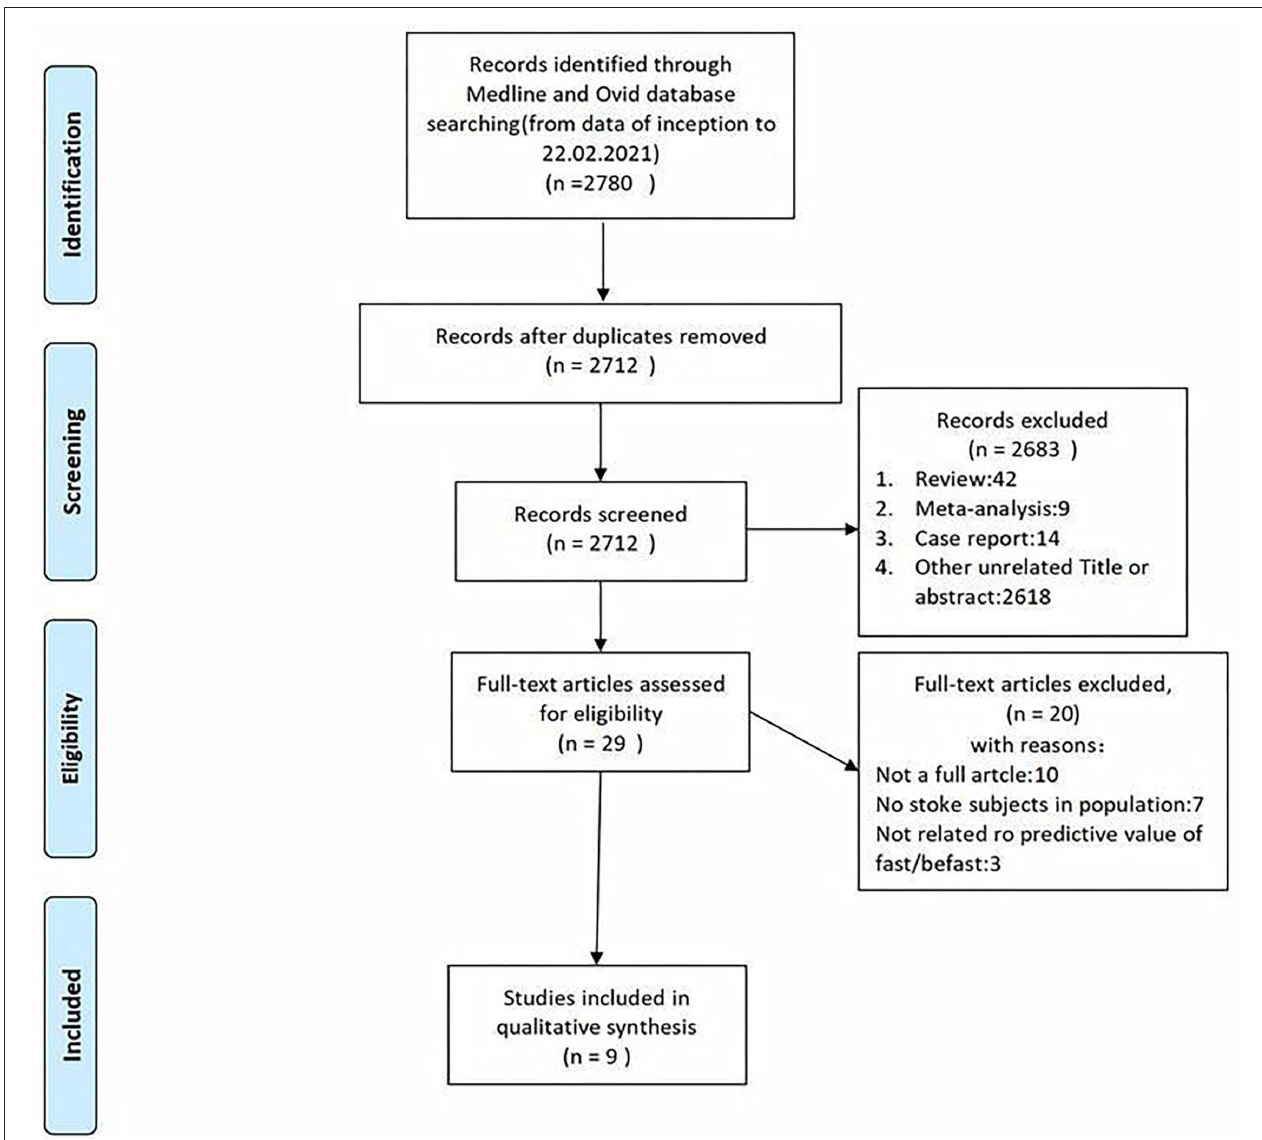
FIGURE 1 | The literature with Face Arm Speech Test (FAST) and Balance, Eyes, Face, Arm, Speech, Time (BEFAST) screening process of the